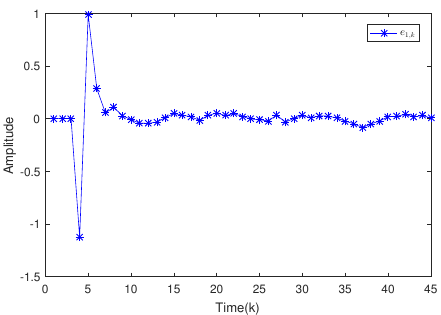
Figure 5. Filtering error e 1, k under the RAP scheduling.